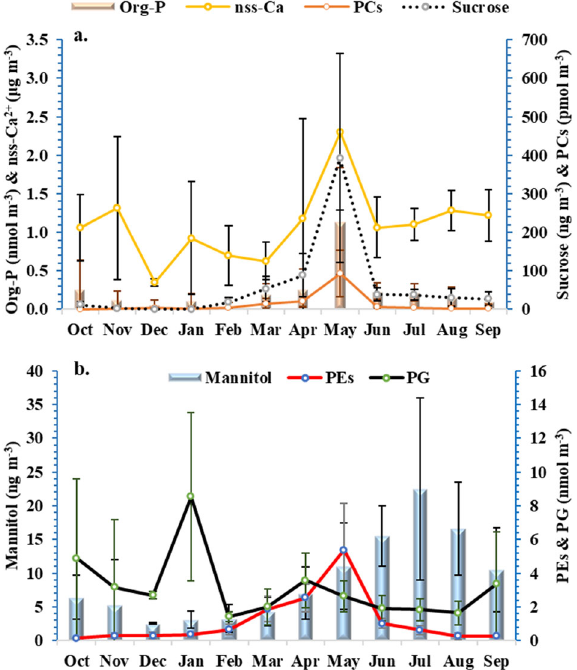
Fig. 1 The monthly variation of org-P, along with bioaerosol tracers. a PCs, sucrose & dust tracer (nss-Ca 2 + ) and ( b ) mannitol, PEs, PG in total suspended particles over the eastern Mediterranean area. The error bars represent the standard deviation of the monthly